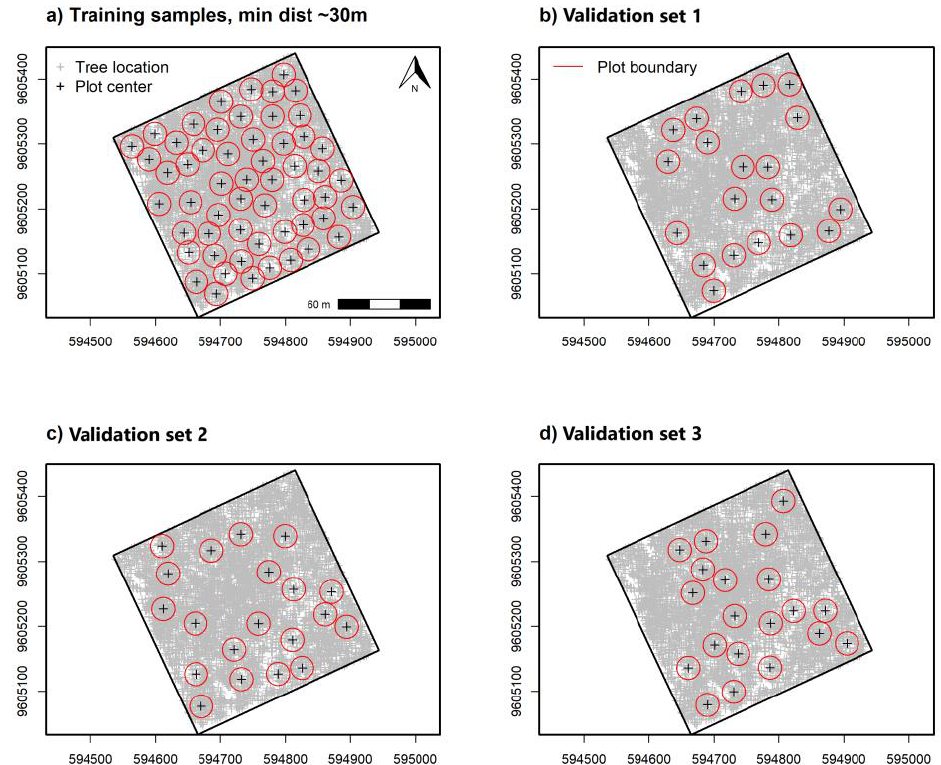
Figure 2. Randomly spaced 0.10 ha circulate plots for remote sensing-based α -diversity model ( a ) training and separate ( b ), ( c , d ) model validation sample data with a minimum distance of 30 m apart at plot center. Three separate iterations were used to select random validation samples while reducing spatial alignment with training sample data.